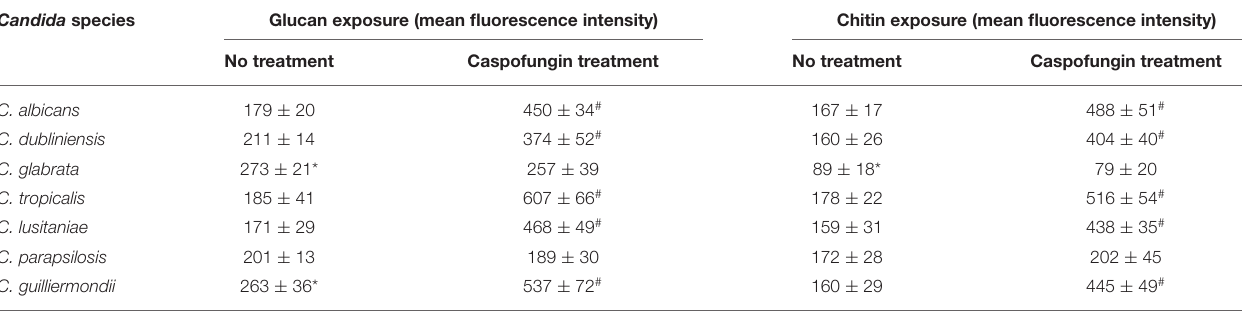
TABLE 5 | Quantification of the exposure of β -1,3-glucan and chitin of Candida species, with and without caspofungin treatment a . Candida species Glucan exposure (mean fluorescence intensity) Chitin exposure (mean fluorescence intensity) No